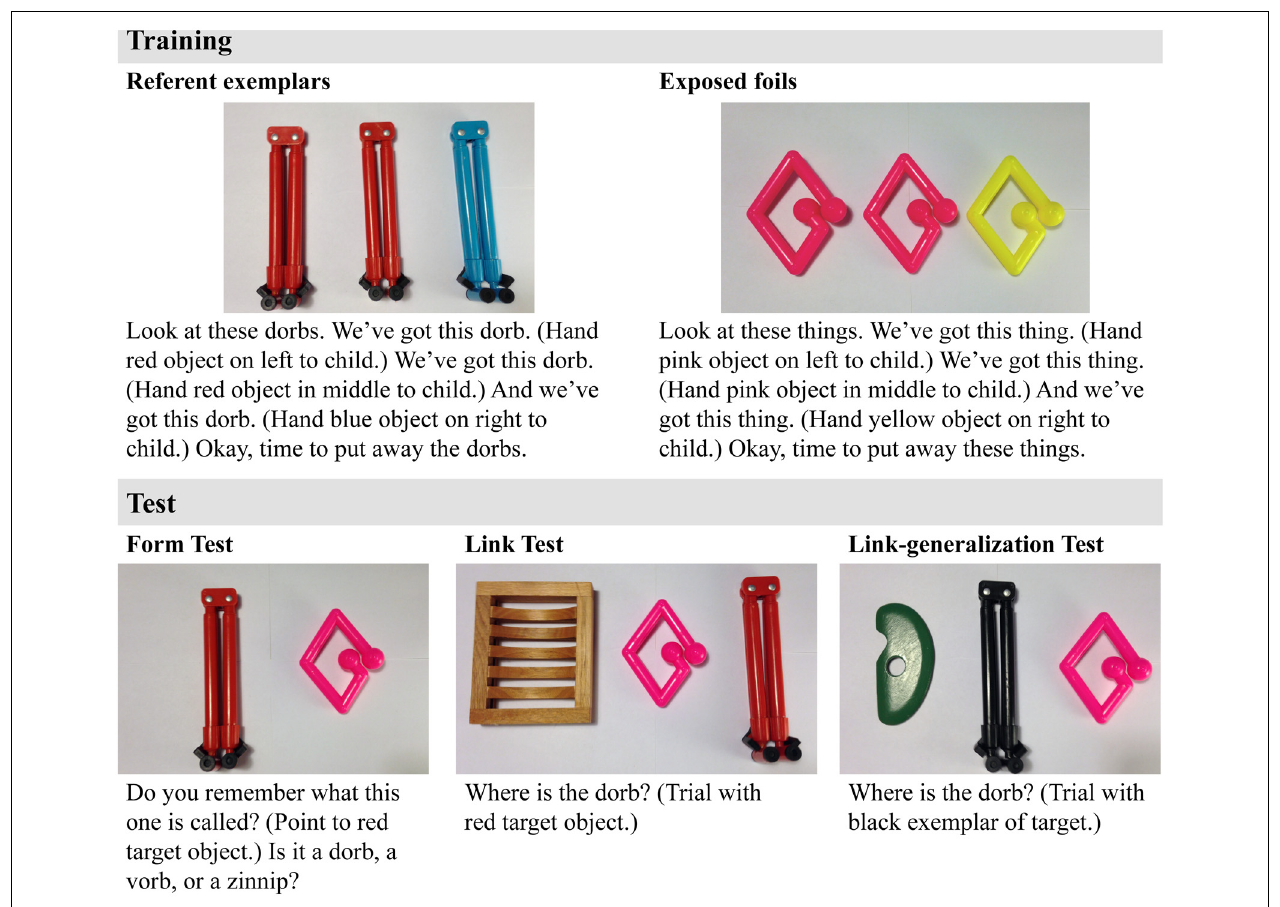
FIGURE 2 | Script used during the training and testing